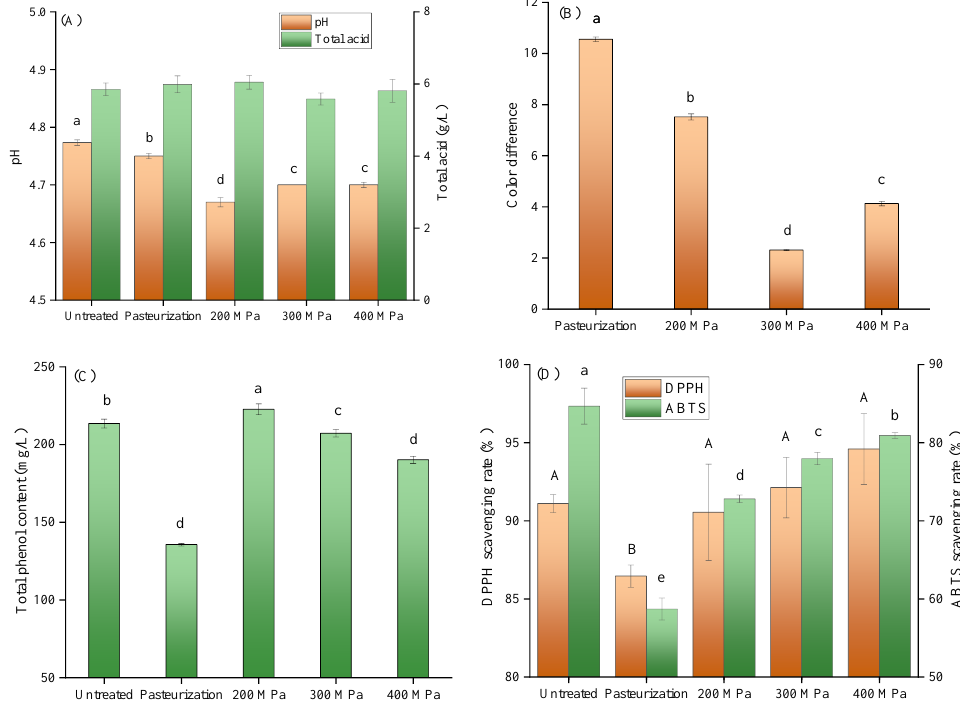
Figure 1. Effects of different treatments on ( A ) total acid and pH values, ( B ) color difference, ( C ) total phenol content, and ( D ) DPPH and ABTS scavenging rate of apple juice. HHP treatment at 200 and 400 MPa for 10 min; pasteurization (85 °C, 15 min). Different small letters indicate significant differences ( p < 0.05) between different samples, and different capital letters indicate significant differences ( p < 0.05) in DPPH. Experiments were performed in triplicate; vertical bars indicate ± SD ( p < 0.05).